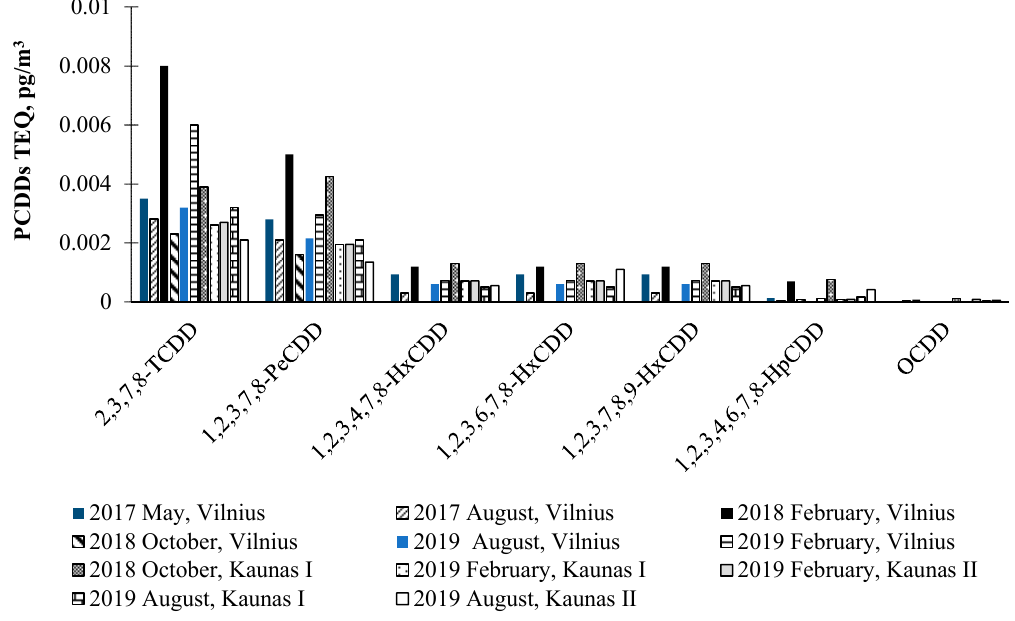
Figure 8. Polychlorinated dibenzo-p-dioxins (PCDDs) toxic equivalent (TEQ) in Vilnius and Kaunas (Vilnius-Lazdynai, Kaunas I-Ramuciai, Kaunas II-Partizanu str.). For comparison, 2,3,4,7,8-PeCDF is predominant in PCDF congeners concentration. The